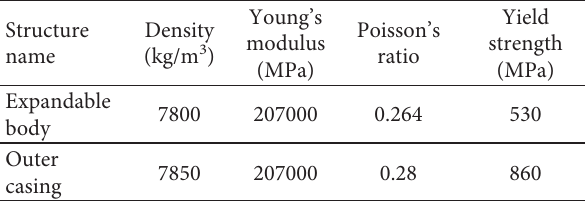
Table 1: Metal material parameters.